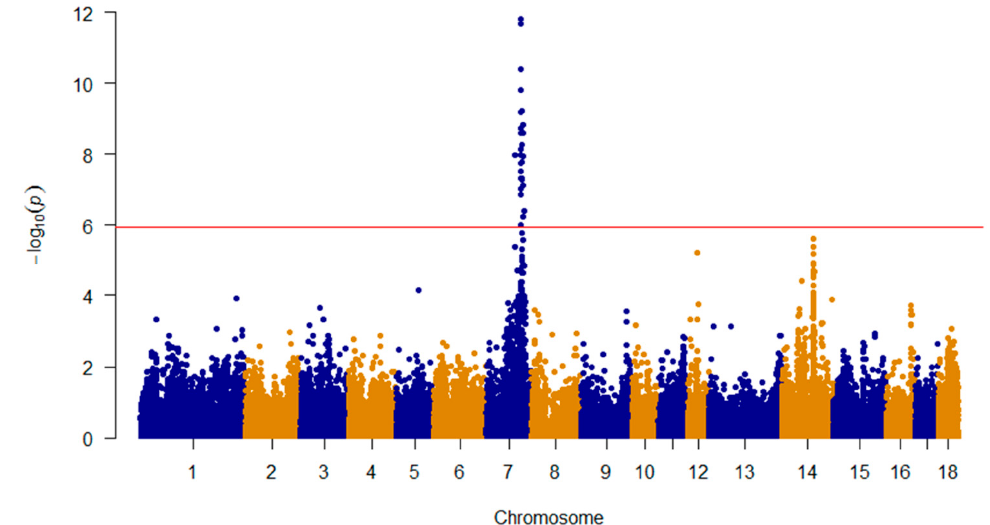
Figure 1. The Manhattan plot for genome-wide association studies for the NTV. The genome-wide association study (GWAS) was run on the NV treated as a covariate based on the 147 SNPs on SSC17 and 39 variants on SSC7 that merged with porcine SNP60K genotyping BeadChip assays. The red horizontal line indicated the Bonferroni significance threshold (1.10 × 10 − 6 ).